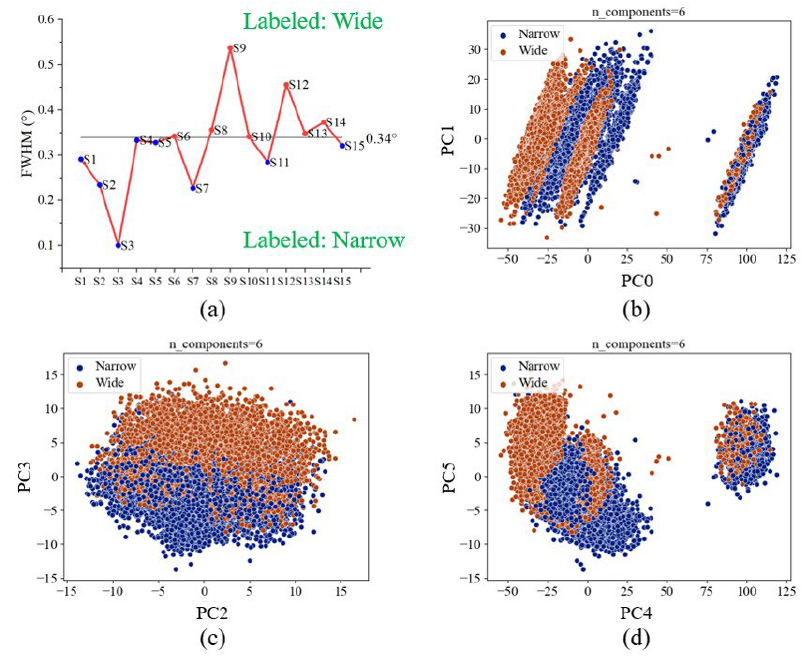
Figure 11. ( a ) The schematics of the labeled data of the FWHM model. ( b ) The first vs. second principal components (PC0 and PC1). ( c ) The third vs. fourth principal components (PC2 and PC3). ( d ) The fifth vs. sixth principal components (PC4 and PC5).